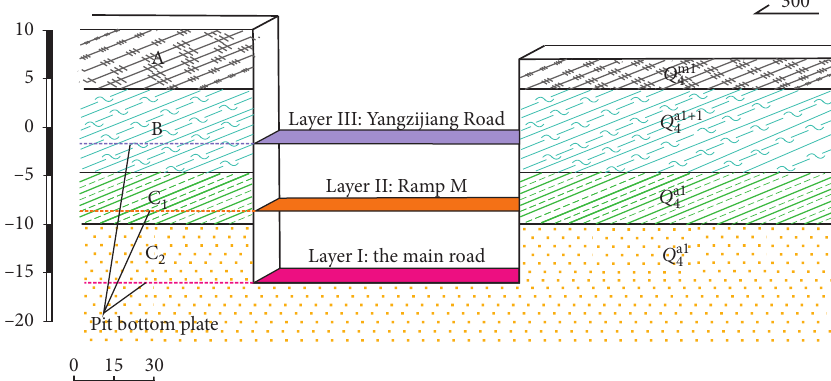
Figure 3: Excavation cross section of the “pit in pit” in the underground interchange